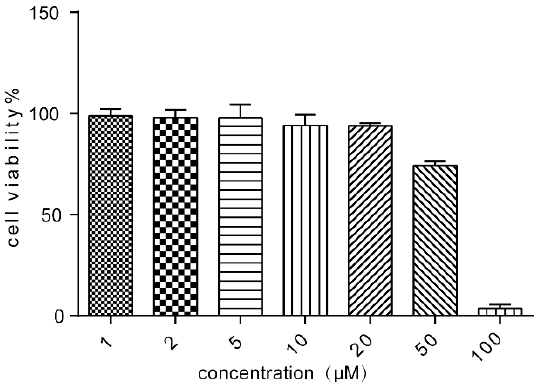
Figure 2. Cell viability of various concentrations of ALI on Caco-2 cells. Results were means ± SEM of three separate experiments.